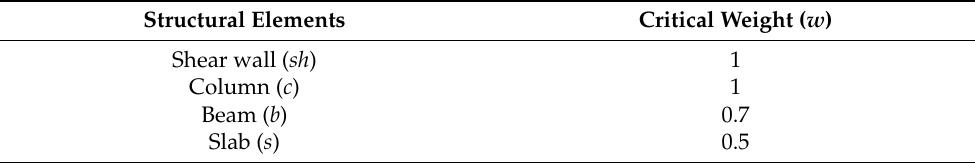
Table 1. Structure element critical